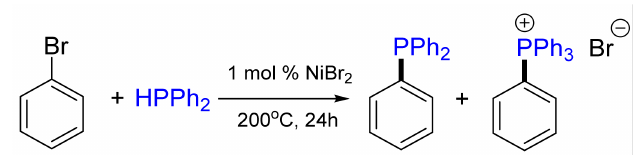
Figure 5. Nickel-catalyzed arylation of